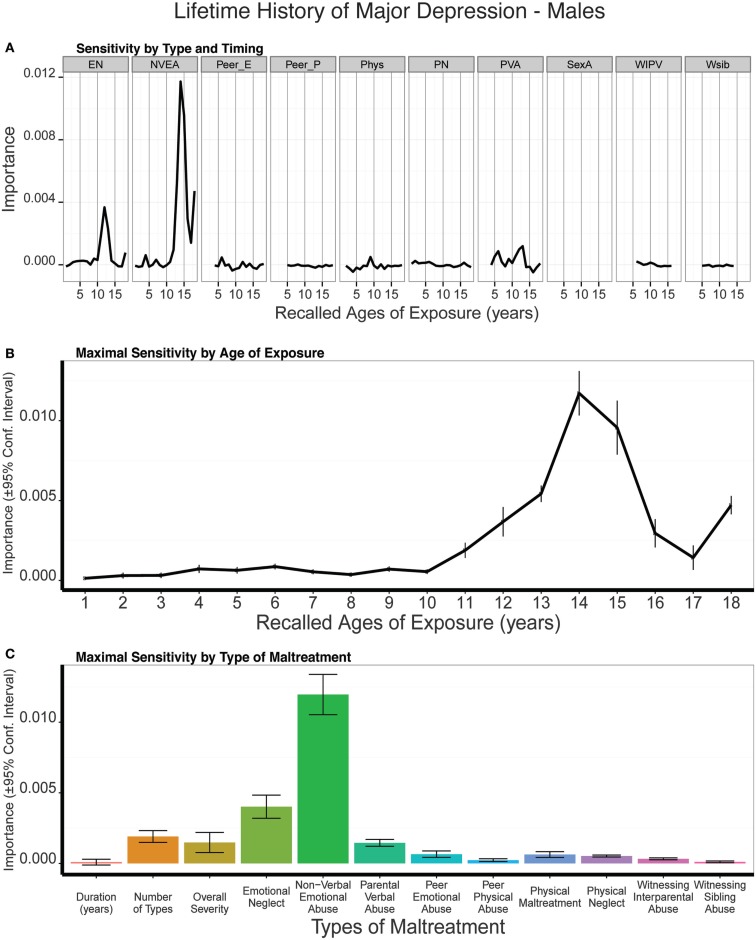
(A) Mean importance of age of exposure for each type of maltreatment in predicting history of major depressive disorder in males. Values are missing for ages of exposure for some types of maltreatment if <5% of subjects reported exposure at that age. (B) Maximal importance of age of exposure (regardless of type) and (C) maximal importance of type of maltreatment (regardless of age) in predicting history of major depressive disorder in males. Abbreviations: EN = emotional neglect, NVEA = non-verbal emotional abuse, Peer E = peer emotional maltreatment, Peer P = peer physical maltreatment, PN = physical neglect, PVA = parental verbal abuse, SexA = sexual abuse, WIPV = witnessing interparental violence, Wsib = witnessing violence to siblings.